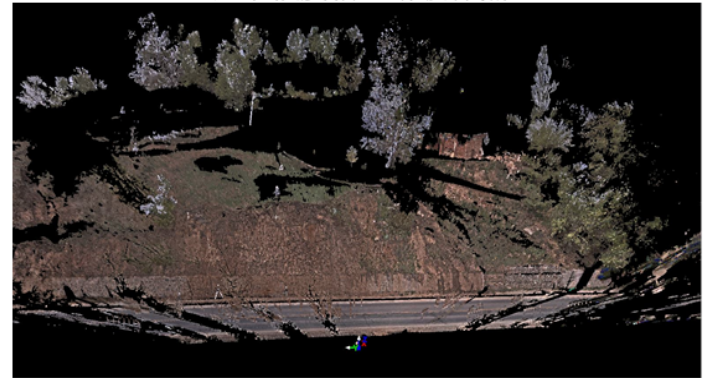
Figure 12. Point cloud of phase 1.